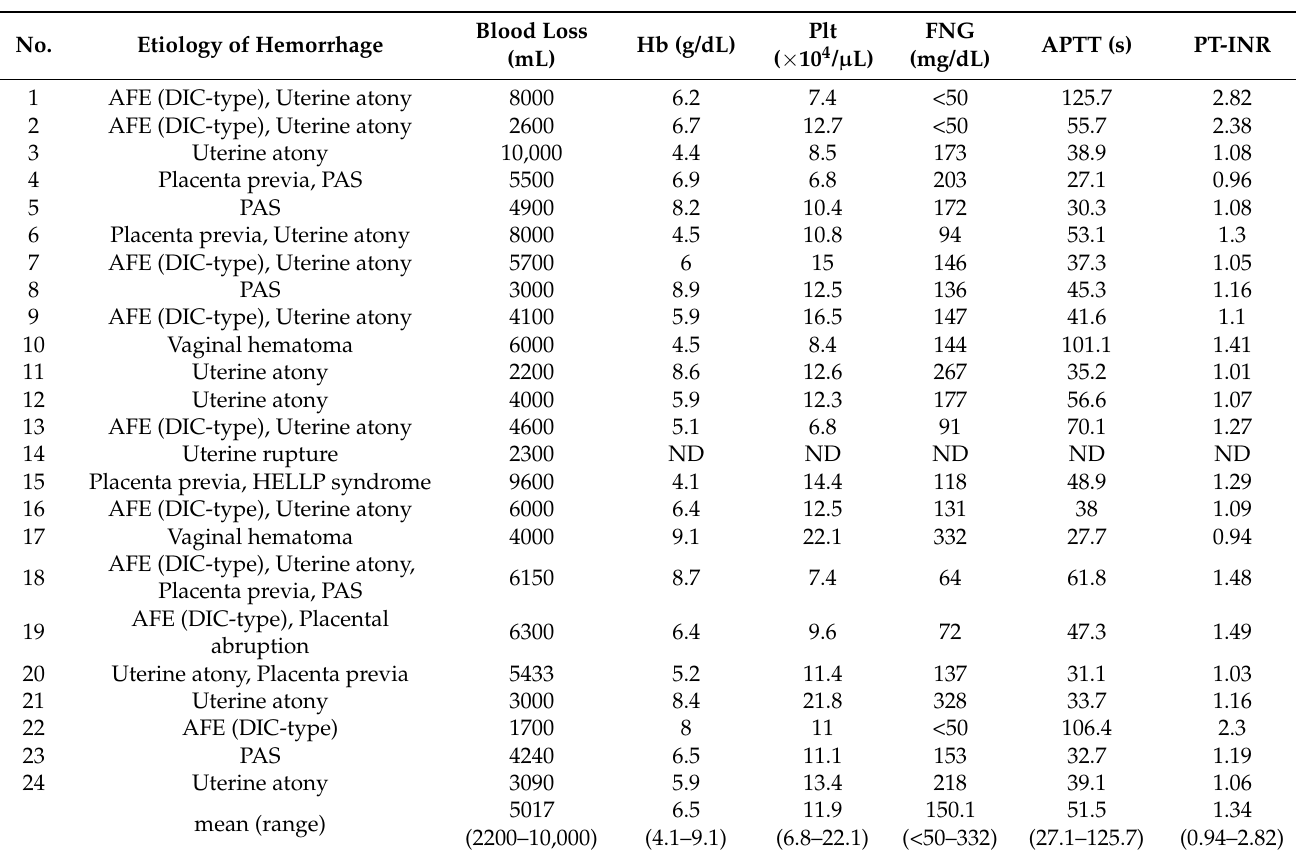
Table 6. Clinical and laboratory parameters at the onset of PPH in patients who received